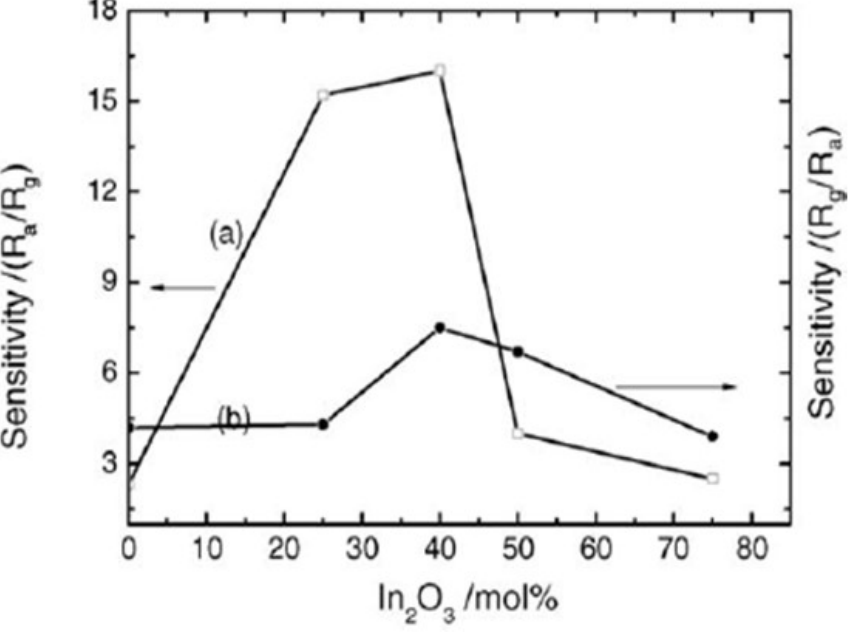
Figure 29. The sensitivity to ( a ) 1000 ppm of CO at 250 °C operating temperature and ( b ) 450 ppm of NO 2 at 150 °C operating temperature for different nanocomposites calcined at 600 °C. (Reprinted with permission from [98]. Copyright 2006, Elsevier). Table 2. Reaction conditions and variation of particle size of SnO 2 nanoparticles prepared by various methods.